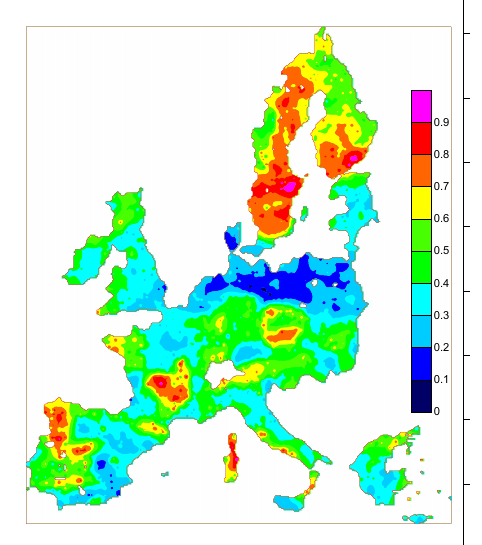
Figure 7. GRHI map created by multiple regression (from [68]).